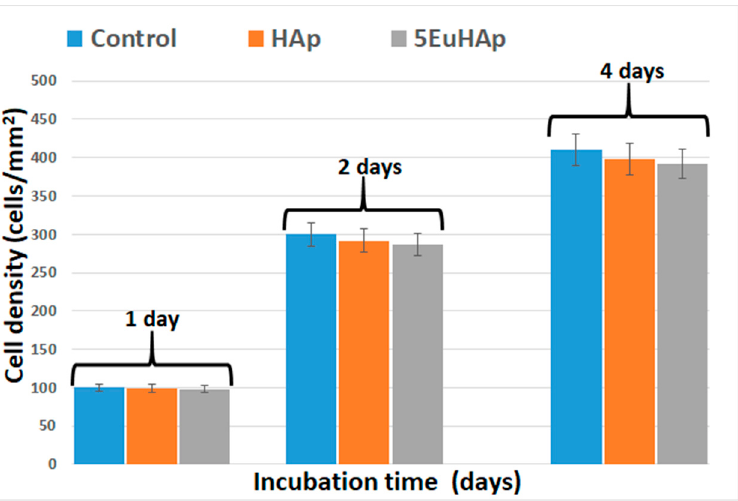
Figure 8. Cell density of osteoblasts (MG-63 cells) on HAp and 5EuHAp thin films for different incubation times.